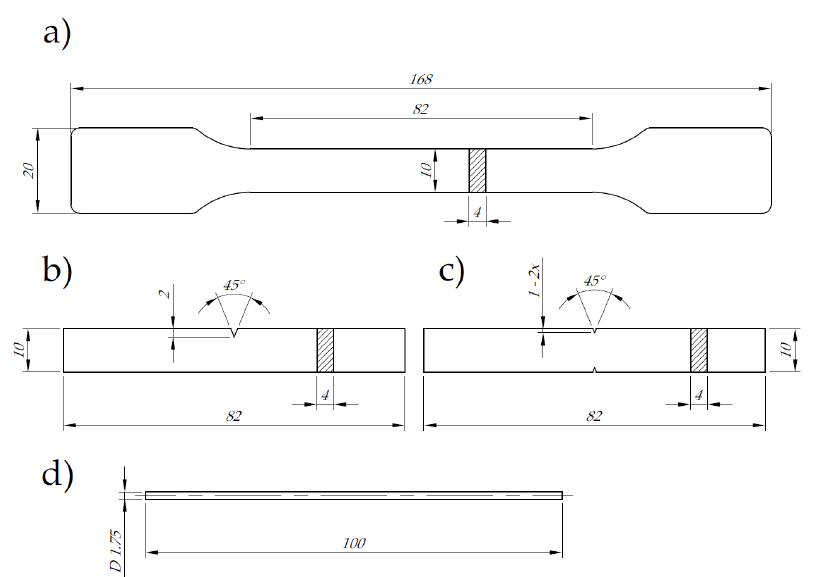
Figure 1. Test specimens used in the tests in accordance with the standards (dimension in mm): ( a ) static tensile strength (ISO 527), ( b ) Charpy impact strength (ISO 179), ( c ) impact tensile strength (ISO 8256), ( d ) filament sample.